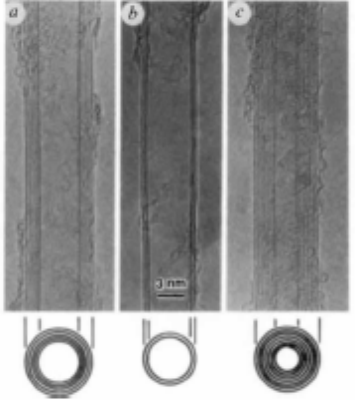
Figure 4. TEM of MWCNTs discovered by Iijima in 1991. Adapted from reference [4], with permission from Nature. Iijima, S. Helical microtubules of graphitic carbon. Nature 1991 , 354 ,